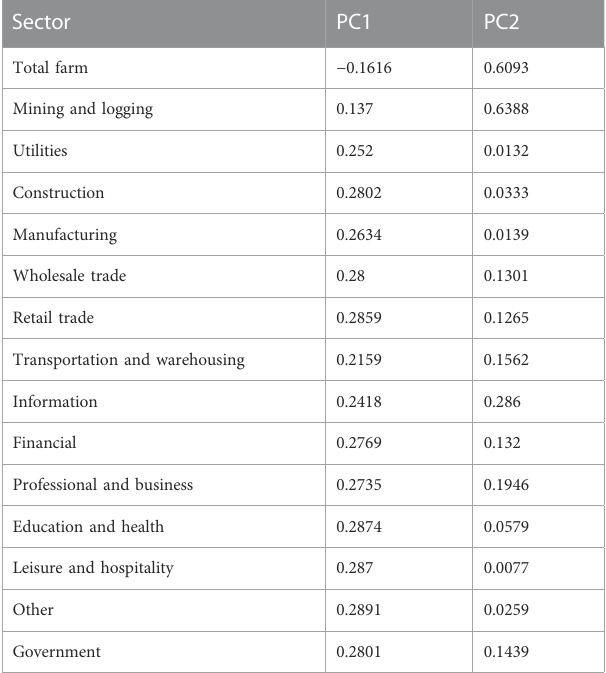
TABLE 3 Principal components loadings of sectors on the fi rst two principal components.